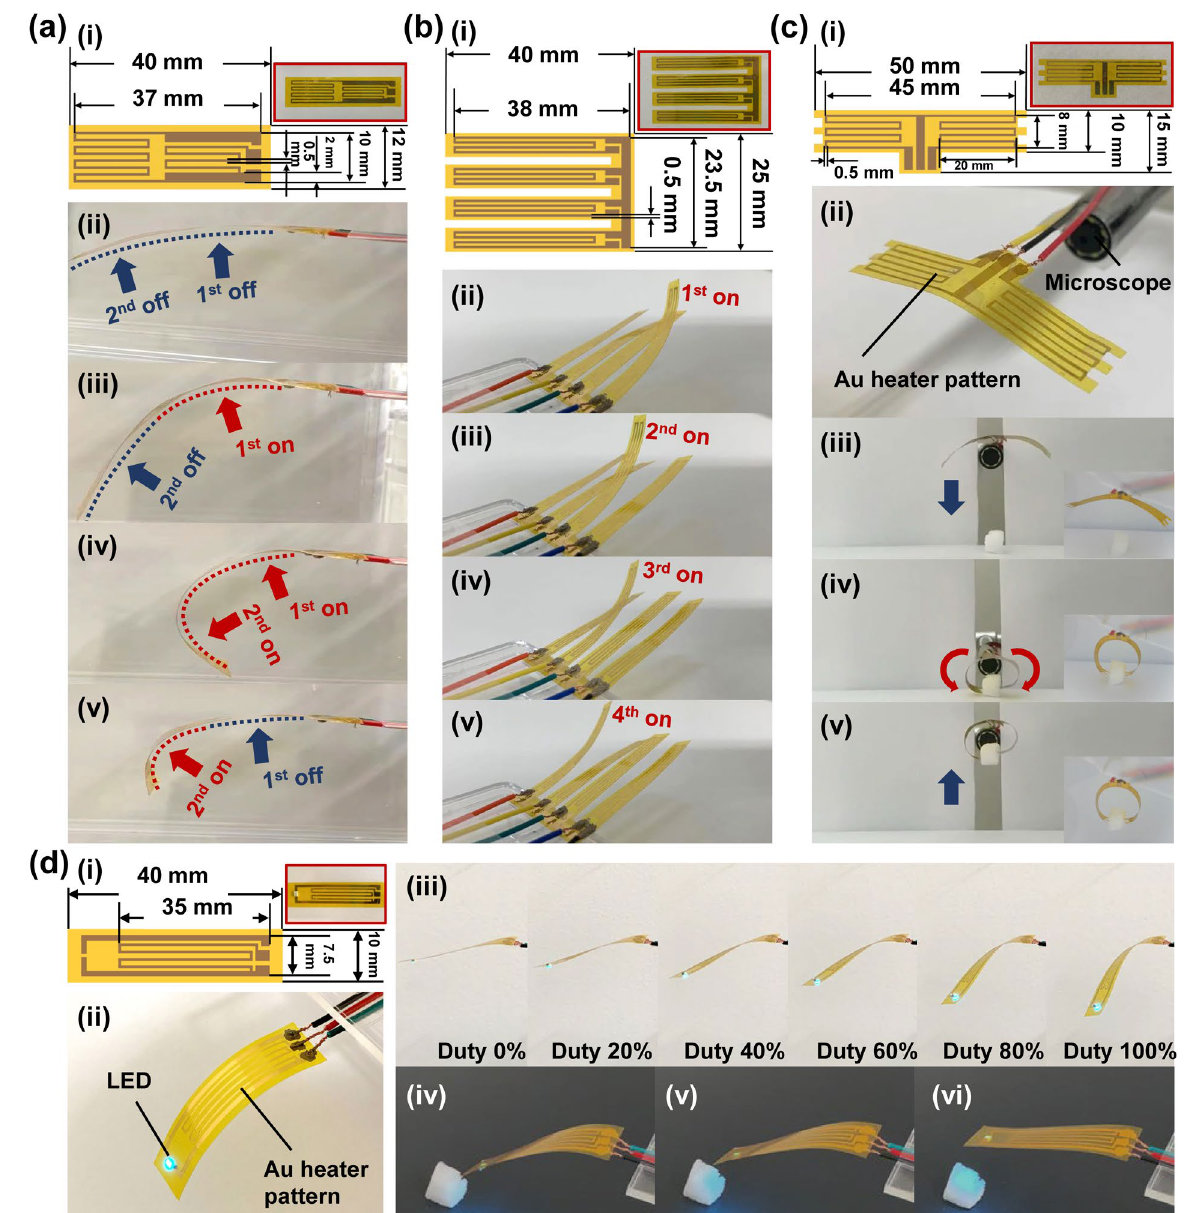
Figure 4. Multi-degree-of-freedom (DOF) film microrobots. ( a ) A two-joint single-finger robot: (i) Design and photograph; (ii) Initial state of the finger robot; and (iii–v) In-plane motion by 2 DOF control. ( b ) A four-fingered array robot: (i) Design and photograph; (ii–v) Sequential independent finger actuations. ( c ) A two-fingered gripper robot: (i) Design and photograph; (ii) Gripper mounted on a microscope probe; and (iii–v) Gripping of styrofoam cube by 2 DOF control. (Inset) view from mounted microscope. ( d ) Design (i) and photograph (ii) of a mobile illuminator robot; (iii) Illumination positions with different duty ratios using a 5 V PWM power supply; (iv–vi) Illumination of an object from different lighting